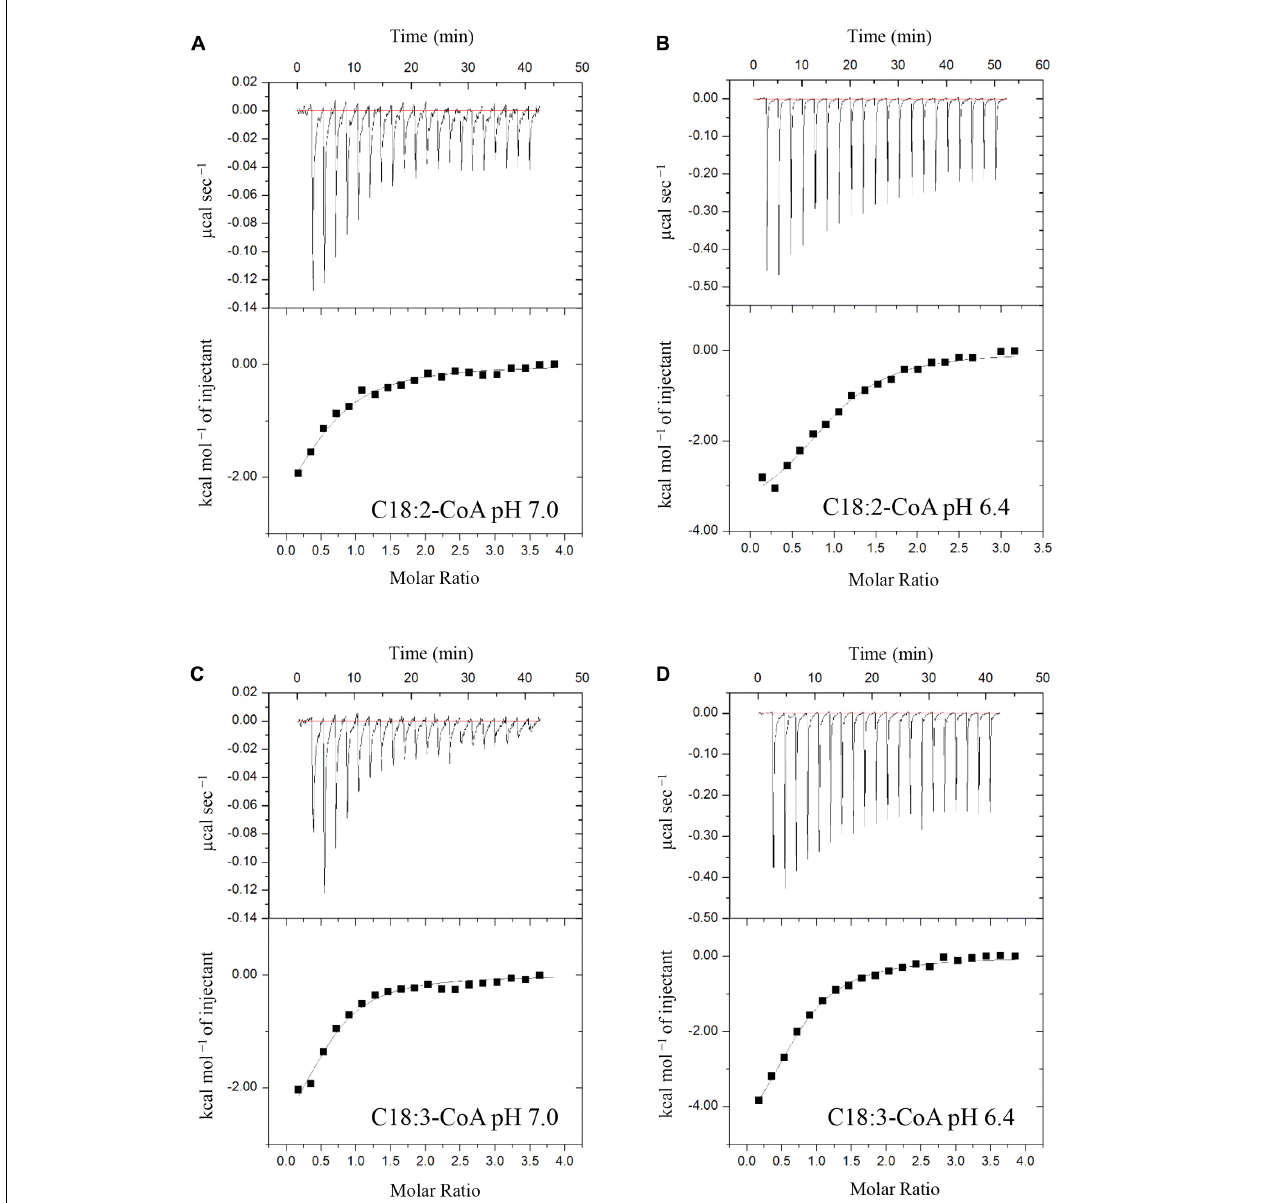
FIGURE 7 | Binding isotherms of recombinant (His) 6 -AtACBP3 titrated with C18:2- and C18:3-CoA esters at 25 ◦ C in isothermal titration calorimetry. The panel shows raw data of 30 µ M recombinant (His) 6 -AtACBP3 titrated with 600 µ M of C18:2-CoA ester, pH 7.0 (A) ; C18:2-CoA ester, pH 6.4 (B) ; C18:3-CoA ester, pH 7.0 (C) and C18:3-CoA ester, pH 6.4 (D) . Each assay had three technical repeats and was repeated at least twice, each using independently prepared (His) 6